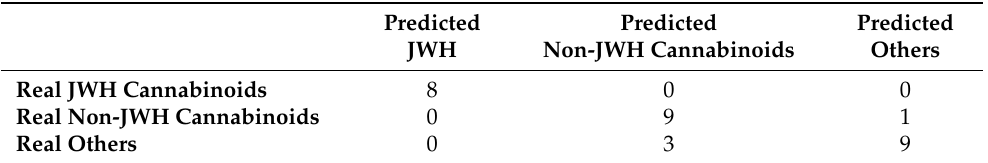
Table 4. Confusion matrix for the analyzed ANN—version 3: 26 (86.7%) tested compounds were correctly classified and 4 (13.3%) were misclassified.